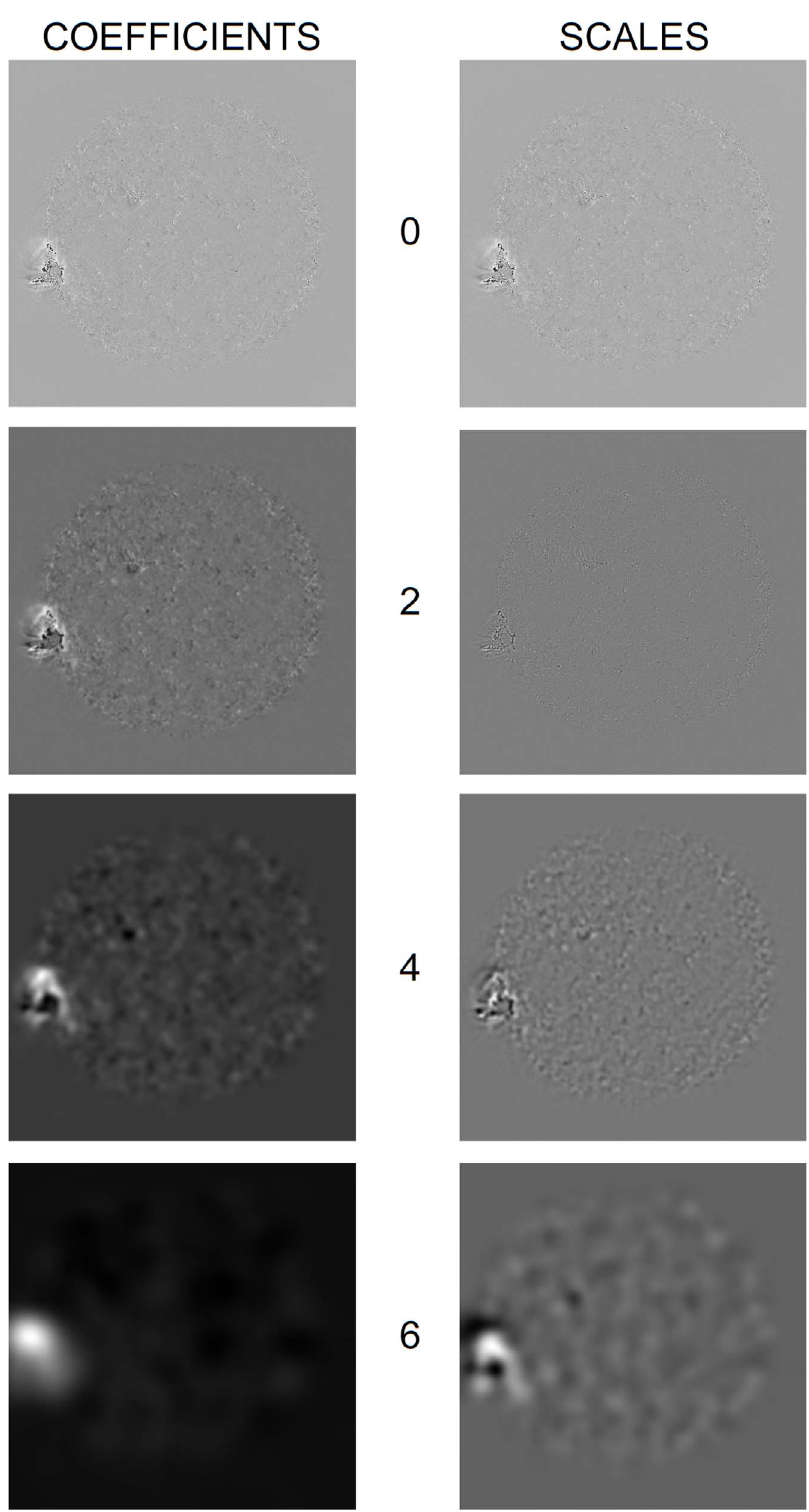
Fig. 1. Wavelet coef fi cients and scales obtained by decomposing a normalized initial image (in this case, an AIA 193-channel base difference) after thresholding and shifting so that the values fi t into [0, 1] interval. Left panels: Wavelet coef fi cients at decomposition levels 0, 2, 4, 6. Right panels: Corresponding wavelet scales at the same decomposition